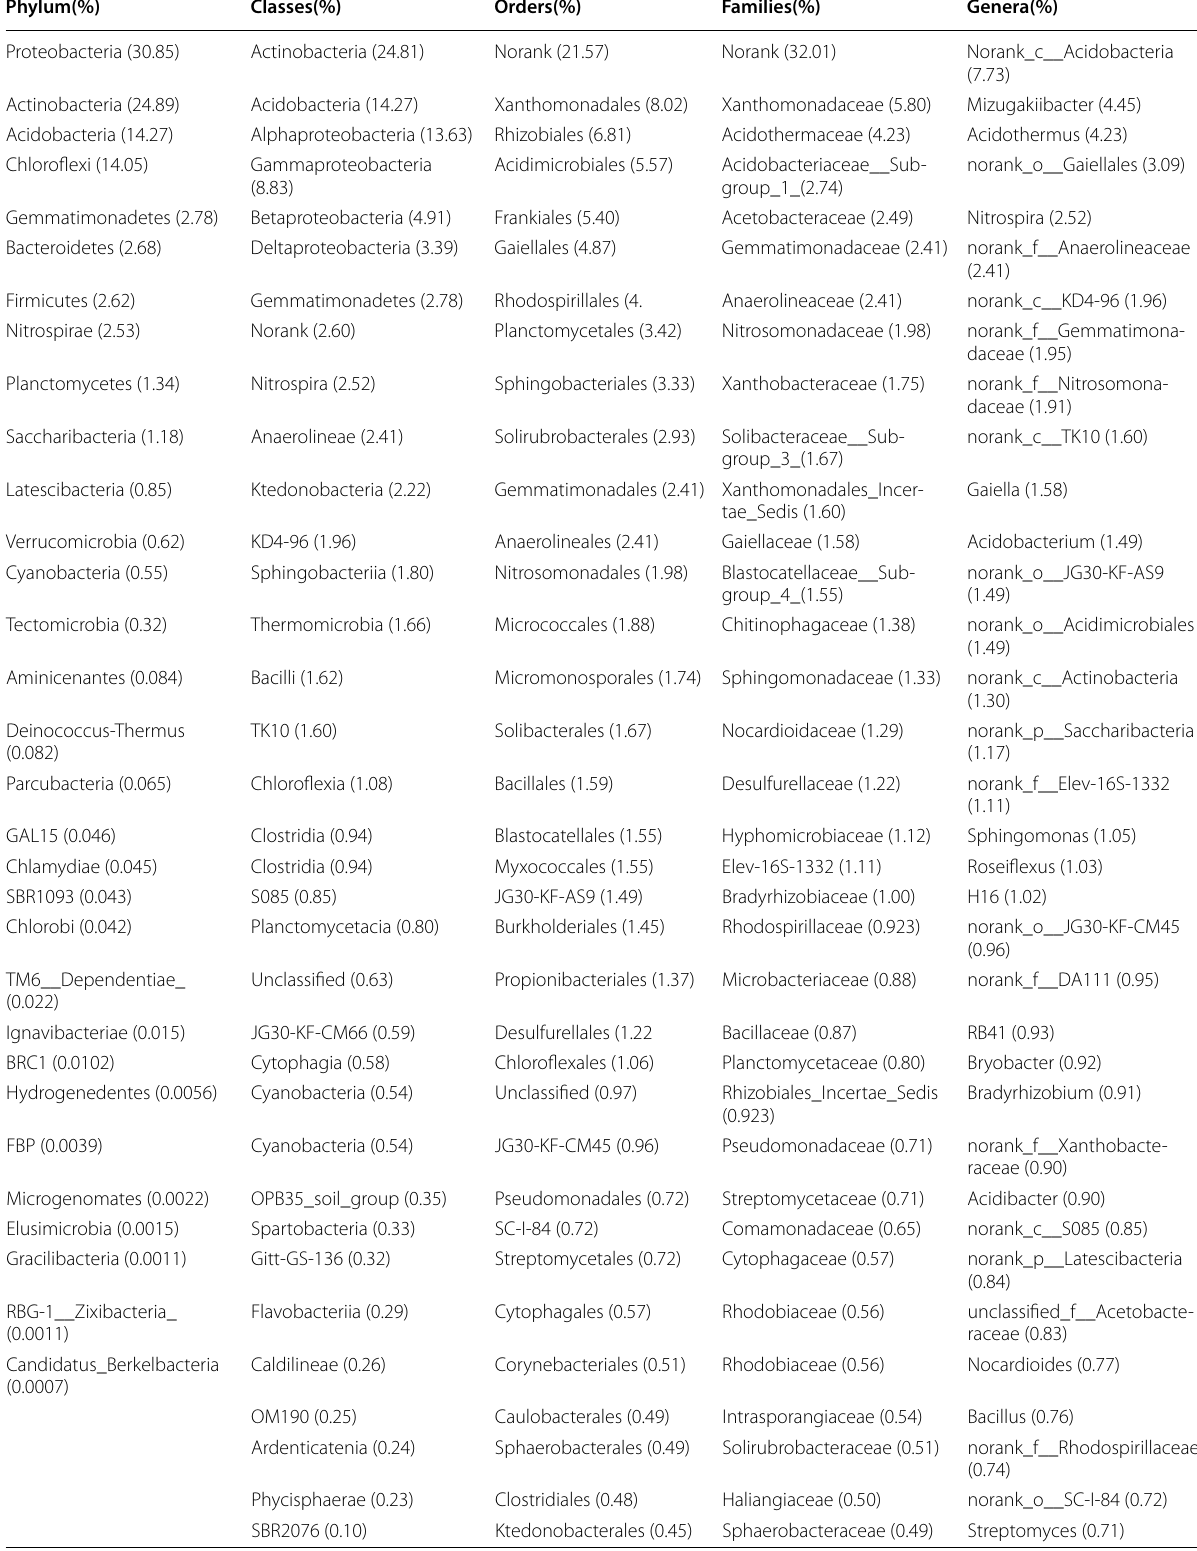
Table 4 Relative abundance of the dominant bacterial phylum, classes, orders, families, and genera in the citrus